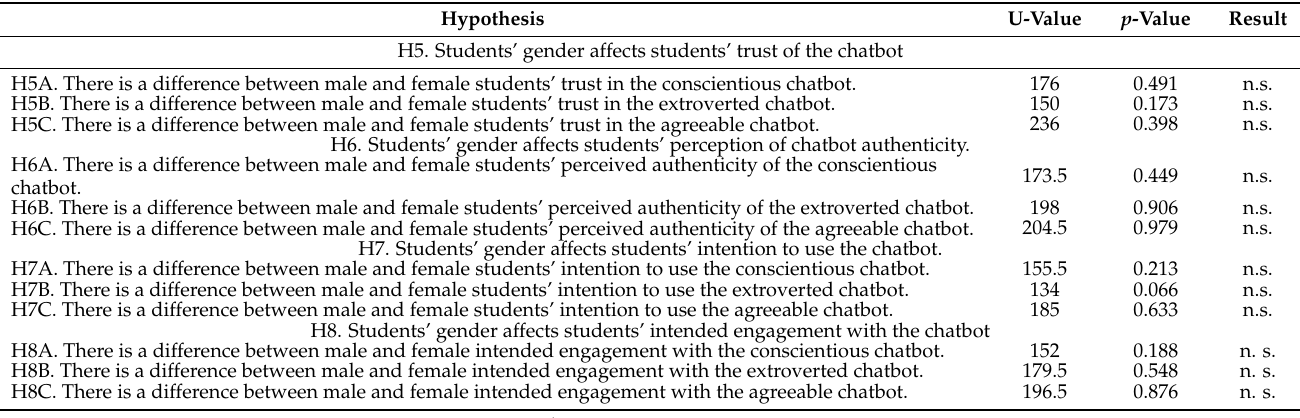
Table 7. Testing of Hypotheses